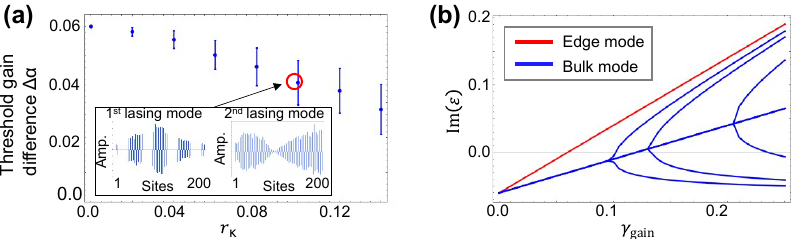
Figure 4: Robustness against inhomogeneous coupling strengths. (a) Threshold gain difference between the first and second lasing modes as a function of coupling disorder r 𝜅 in a finite system consisting of n tri = 100 trivial and n topo = 101 topological cavities. The insets show representative mode profiles of the edge mode and bulk mode. Blue bars indicate the amplitudes on A -site. (b) Imaginary parts of eigenenergies of the system plotted as a function of supplied gain on A -site 𝛾 . The red and blue lines indicate the energy of the edge mode and bulk modes, respectively. The parameters used are 𝜅 gain = 0.06. In (b), the randomness is r = and 𝛾 𝜅 loss